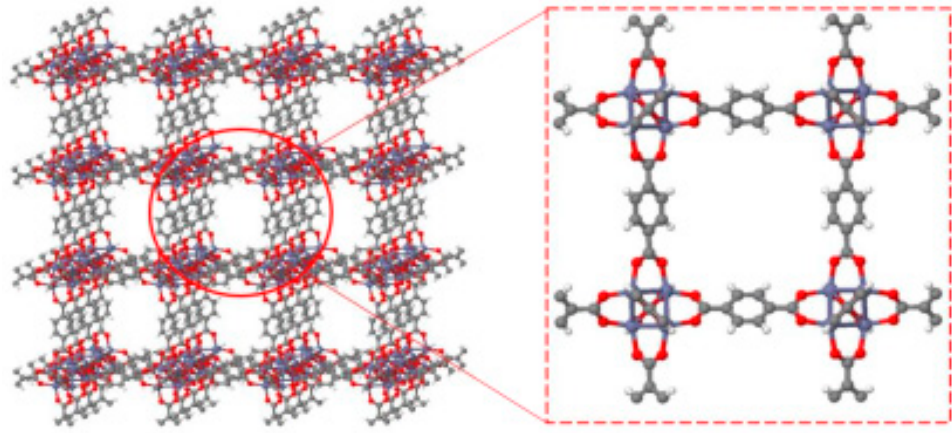
Figure 16. Structure diagram of MOF-5